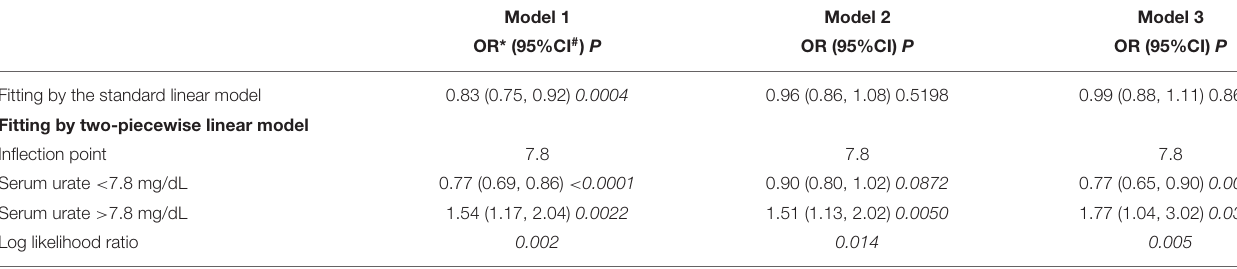
TABLE 3 | Threshold effect analysis of serum urate on migraine using the two-piecewise linear regression